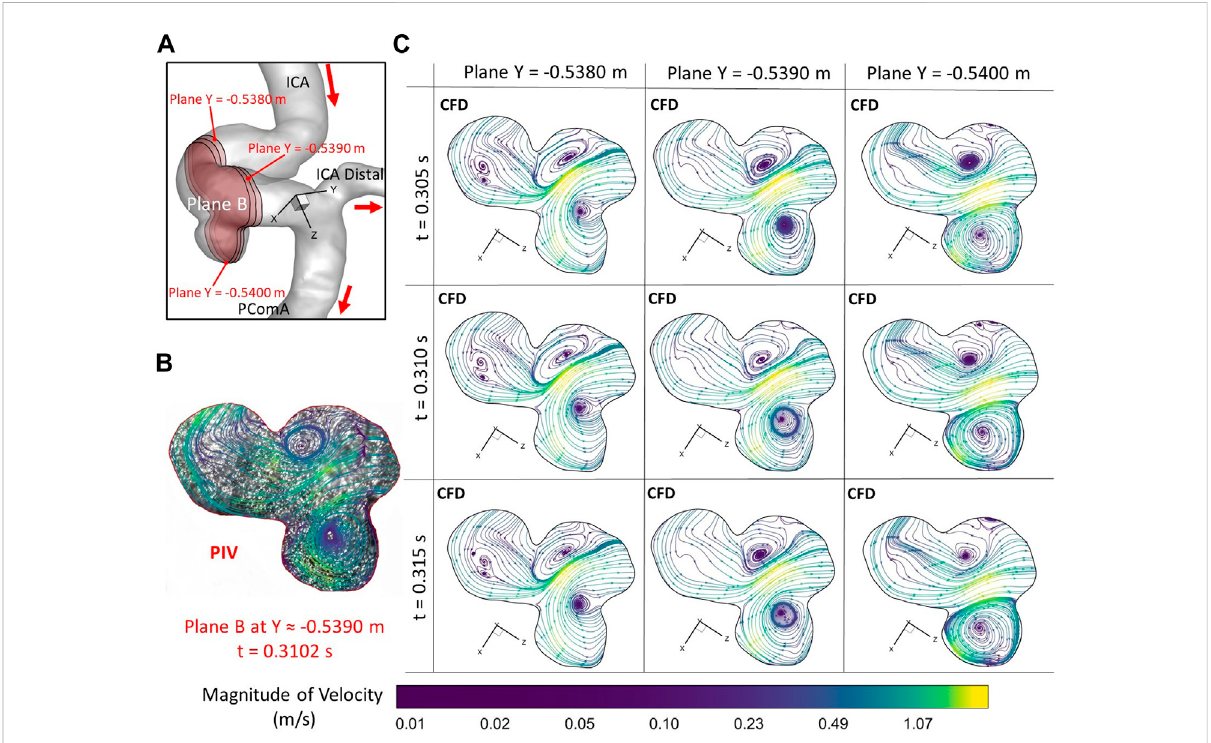
FIGURE 8 Comparisonsof fl ow streamlinesand magnitudes of velocity atthe extracted plane B (i.e., plane Y ≈ − 0.5390 m according to the coordinatesin CFD) between PIV measurements and CFD simulations at the time instant t = 0.3102 s: (A) Schematic planes for the comparisons between PIV and CFD. (B) Distributions of fl ow streamlines and magnitudes of velocity in PIV. (C) Distributions of fl ow streamlines and magnitudes of velocity in